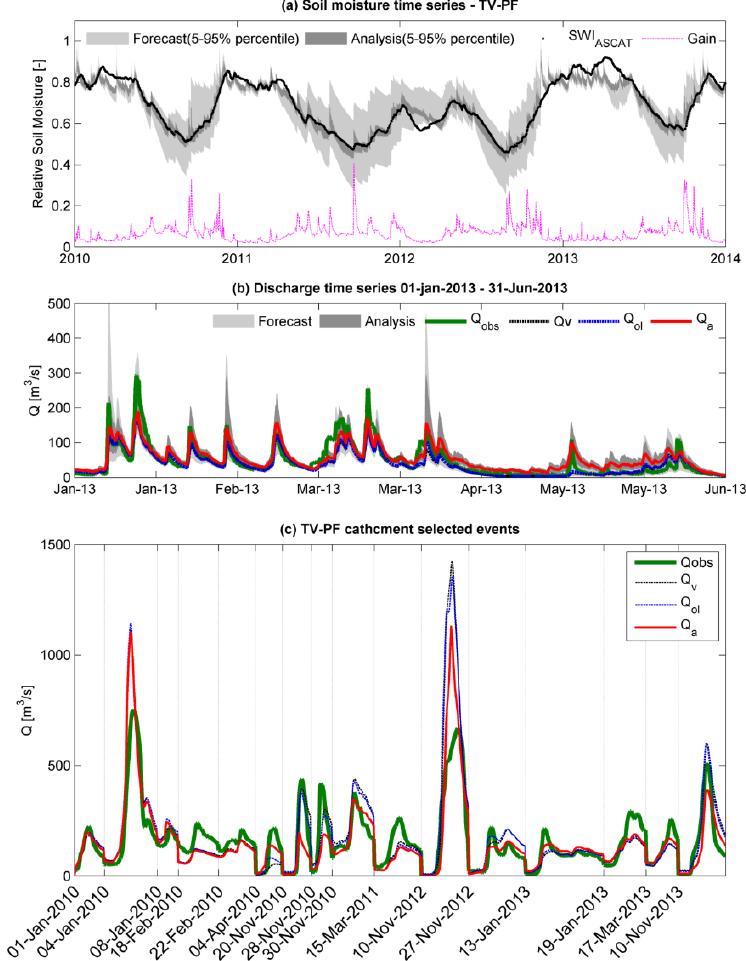
Figure 2. Results of the data assimilation experiment for Tiber River at Ponte Felcino using LS as RT and an observation error equal to 7%. ( a ) Plots the satellite SM time series along with the ensemble forecast and analysis (5%–95% percentiles). In purple, it is also shown the Kalman gain. ( b ) Plots a small part of the discharge time series: the plot of the entire time series is not shown because of problems of visualization. In the panel, Q obs is the observed discharge, Q v is the discharge obtained in validation, Q ol is the ensemble mean and Q a is the updated discharge obtained in assimilation. ( c ) Plots the discharge values for the selected flood